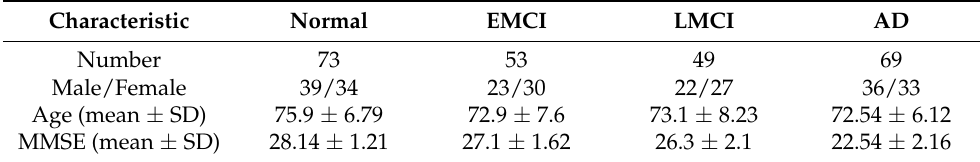
Table 1. The subject’s information.